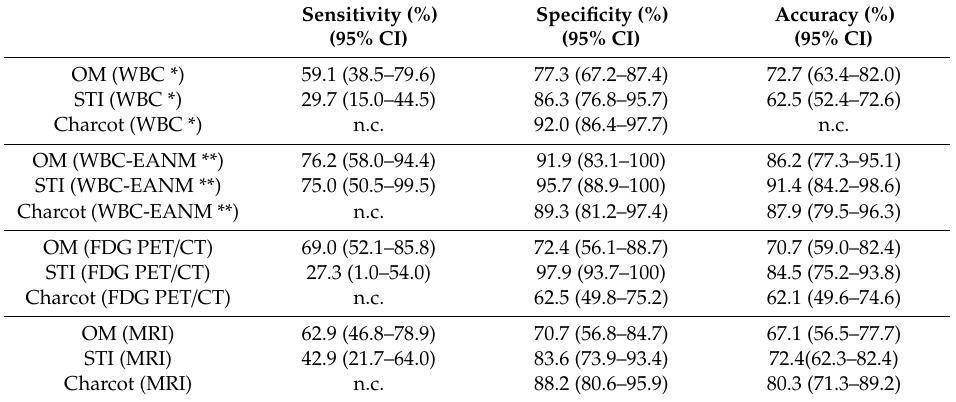
Table 3. Overview of the performance of diagnostic imaging tests in detecting OM, STI, and